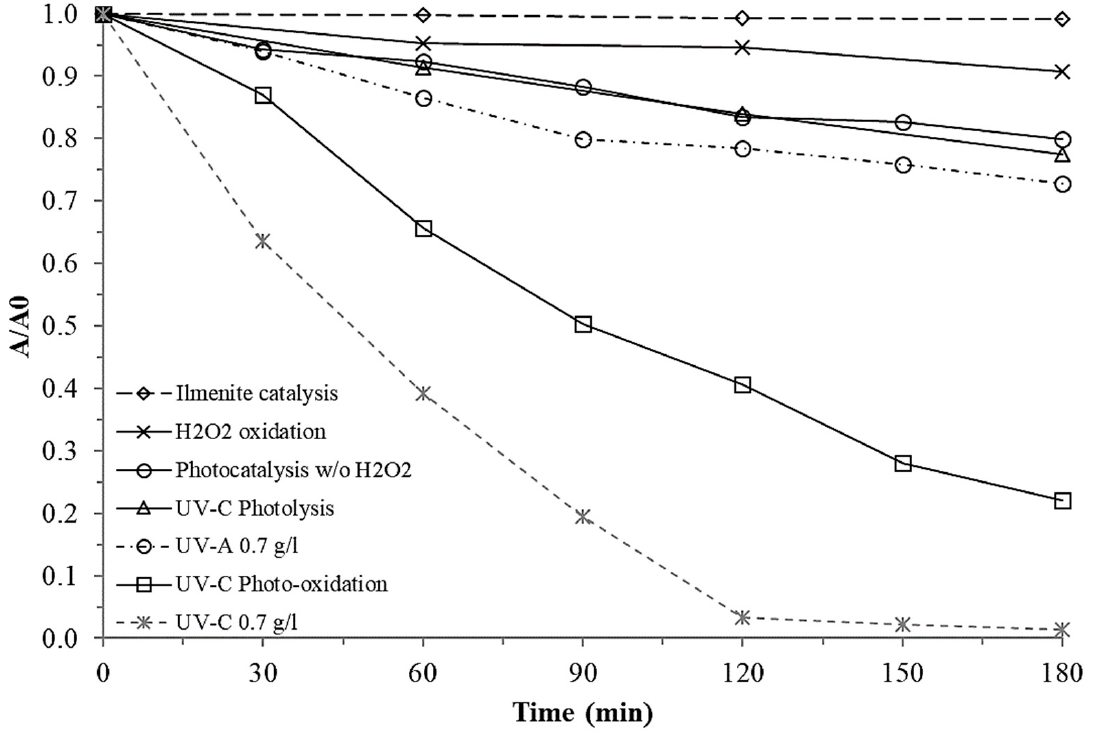
Figure 11. Comparison between ilmenite catalysis without H 2 O 2 and light source, H 2 O 2 oxidation, UV-C direct photolysis, UV-C- H 2 O 2 photo-oxidation, UV-A photocatalysis, UV-C photocatalysis. ([H 2 O 2 ] = 10 mM, pH 0 = 3.8, Ilmenite loading = 0.7 g/L).